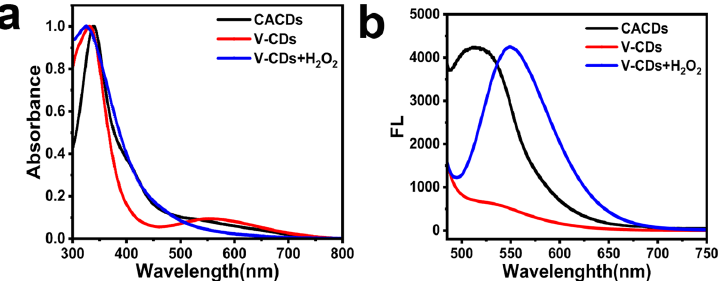
Figure 2. ( a ) UV − vis spectrum of CACDs, V − CDs, and H 2 O 2 treated V − CDs. ( b ) Fluorescence spectra of CACDs, V − CDs, and H 2 O 2 treated V − CDs at excitation wavelengths of 480 nm.